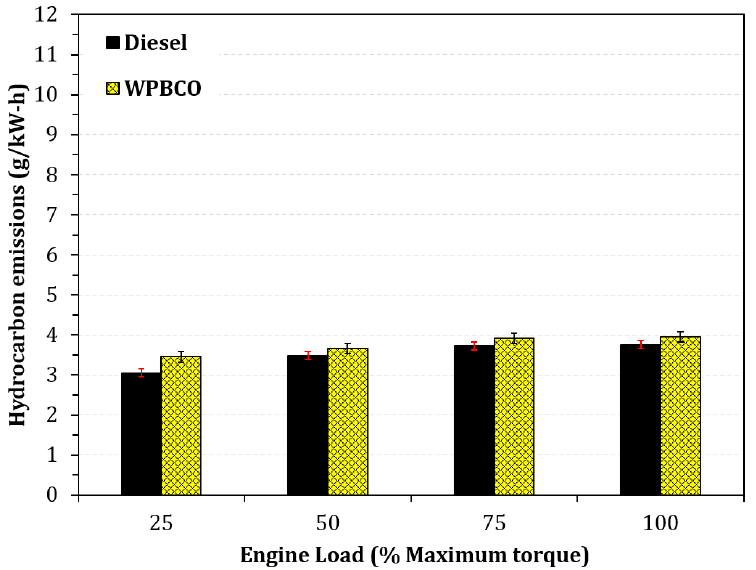
Figure 10. Variation in total hydrocarbon emissions with respect to the engine load.